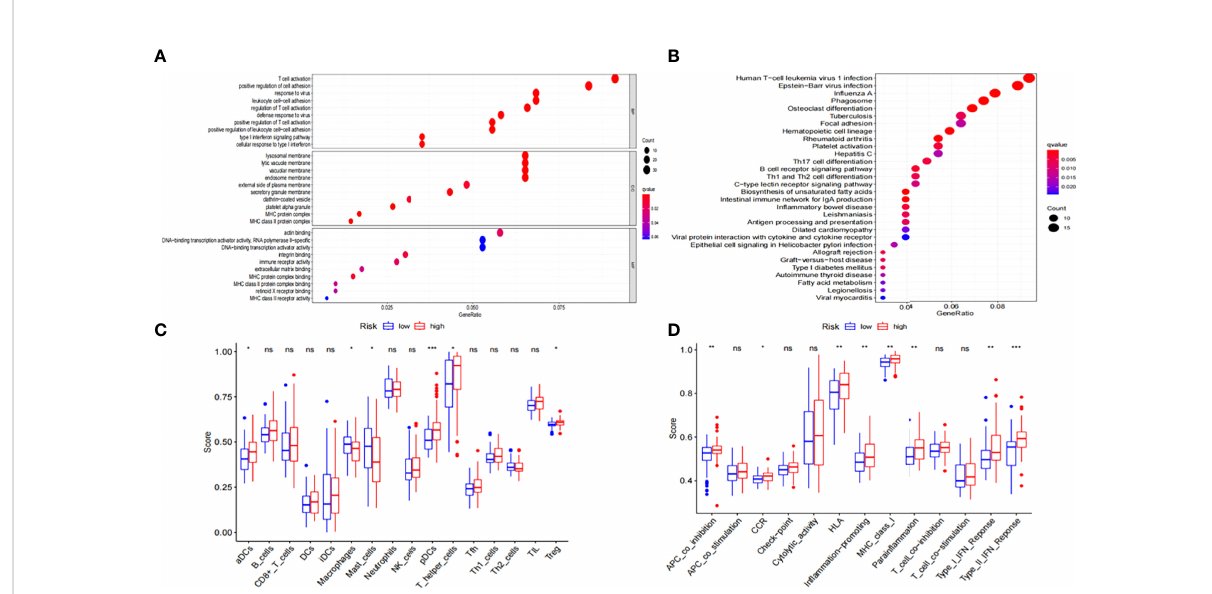
FIGURE 5 Functional enrichment analysis of the DEGs between low-risk and high-risk groups. (A) GO and (B) KEGG enrichment analyses of DEGs in the TCGA-LAML cohort. (C) ssGSEA scores of 16 immune cells and (D) 13 immune-related functions in the TCGA-LAML cohort. DEGs, differentially expressed genes; GO, Gene Ontology; KEGG, Kyoto Encyclopedia of Genes and Genomes; ssGSEA, Single-sample gene set enrichment analysis; NS: not signi fi cant; * P < 0.05; ** P < 0.01; *** P < 0.001.